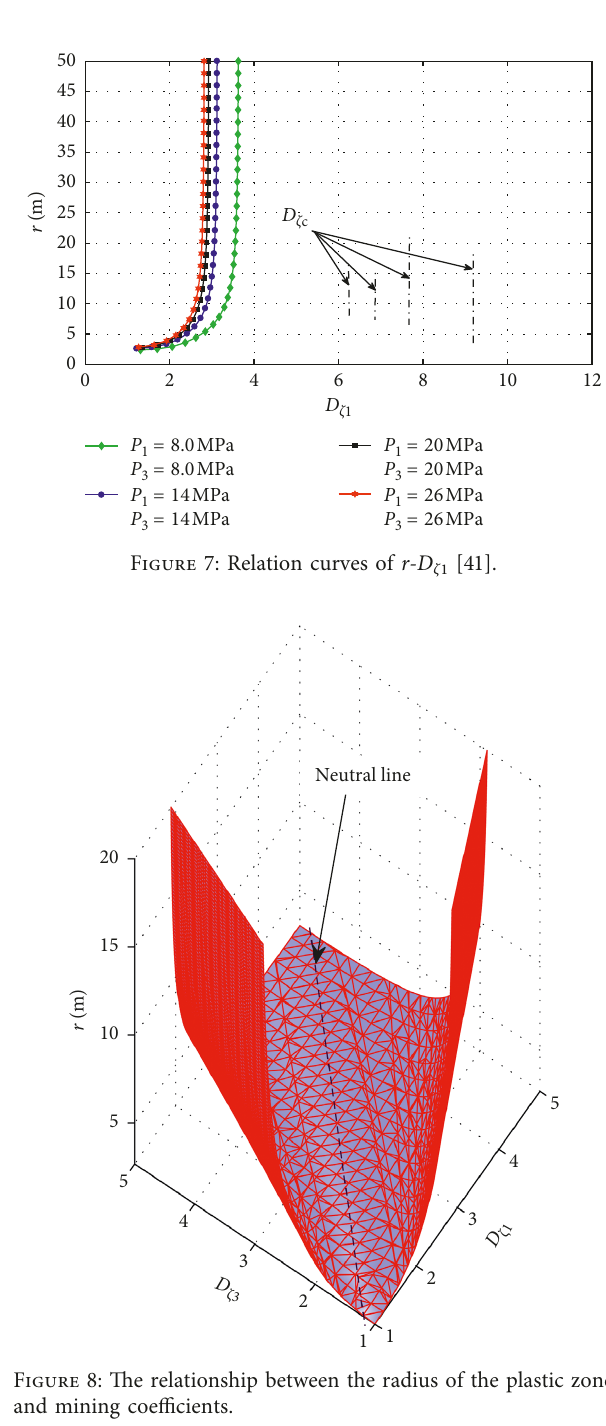
Figure 8: The relationship between the radius of the plastic zone and mining coefficients.